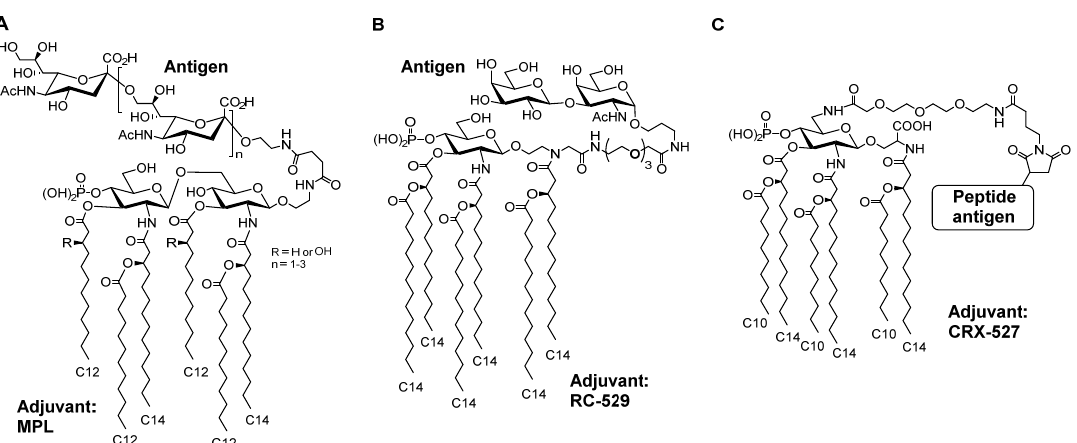
Figure 12. Chemical structures of adjuvant-antigen complexes; ( A ) meningococcal antigen conjugated with MPL adjuvant, ( B ) Thomsen-Friedenreich antigen conjugated with RC-529 ( 11 ) adjuvant, ( C ) peptide antigen conjugated with CRX-527 adjuvant.